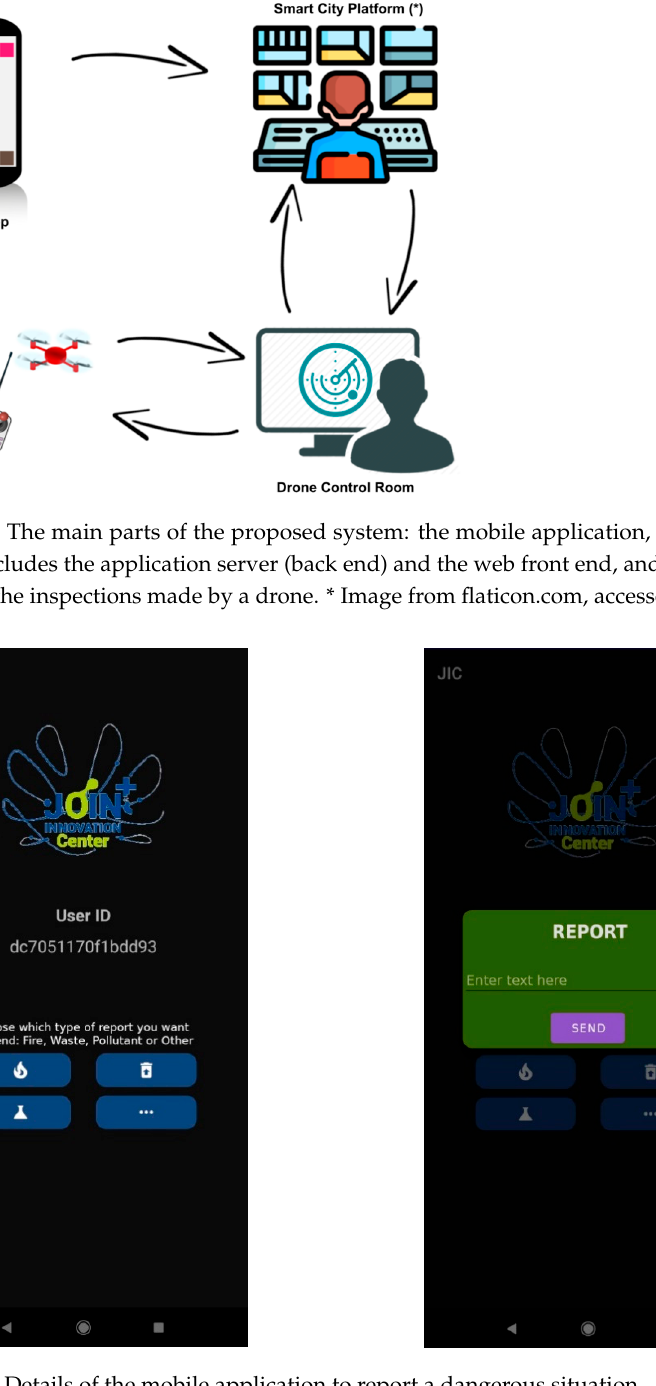
Figure 2. Details of the mobile application to report a dangerous situation.